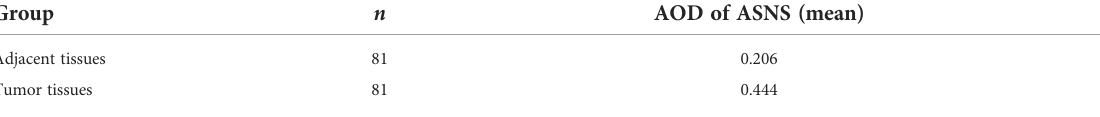
TABLE 1 AOD of ASNS in tumor tissues compared with normal tissues.